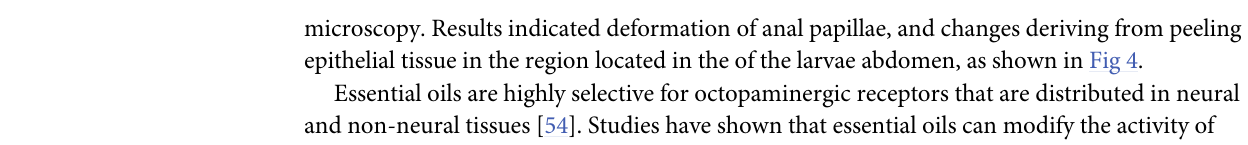
Means within a column with different letters are significantly different. Means within a row with different simblos are significantly different (p-value = 0.001, F = 7,984).